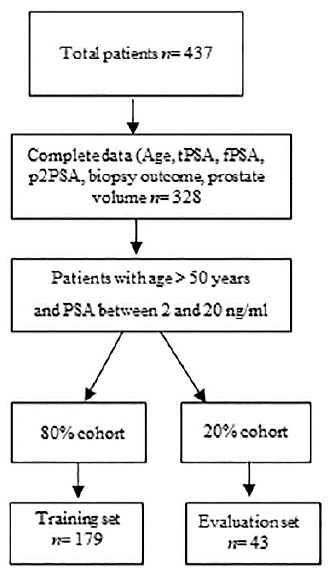
Figure 1. Summary of included patients. Table 1. Characteristics of the study population.